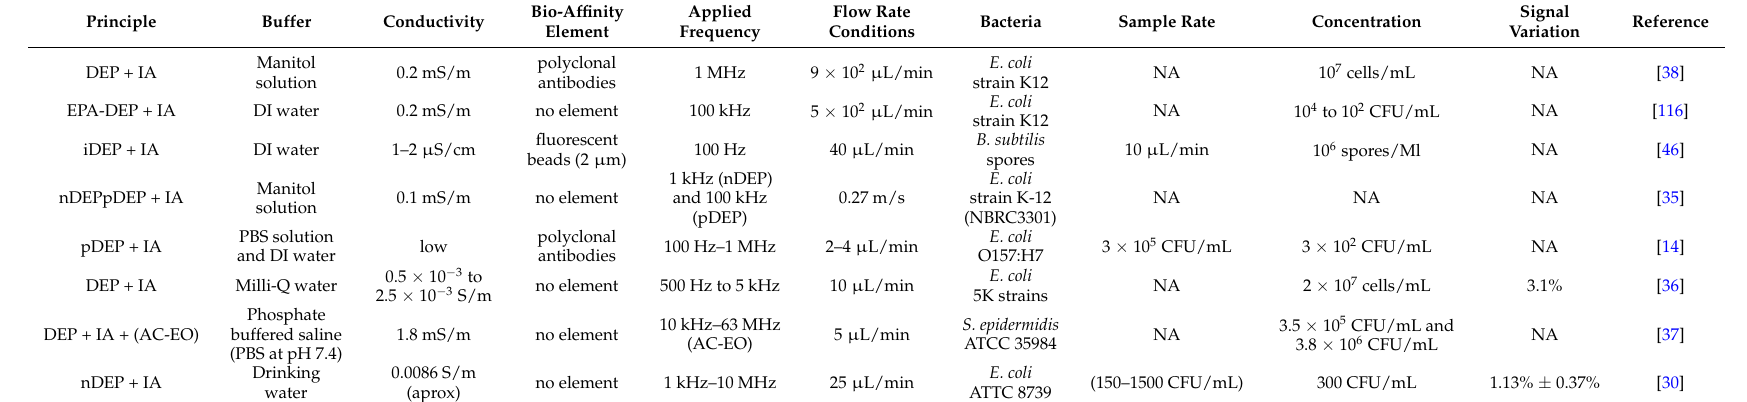
Table 1. Combined dielectrophoresis and dmpedance systems for bacteria concentration and